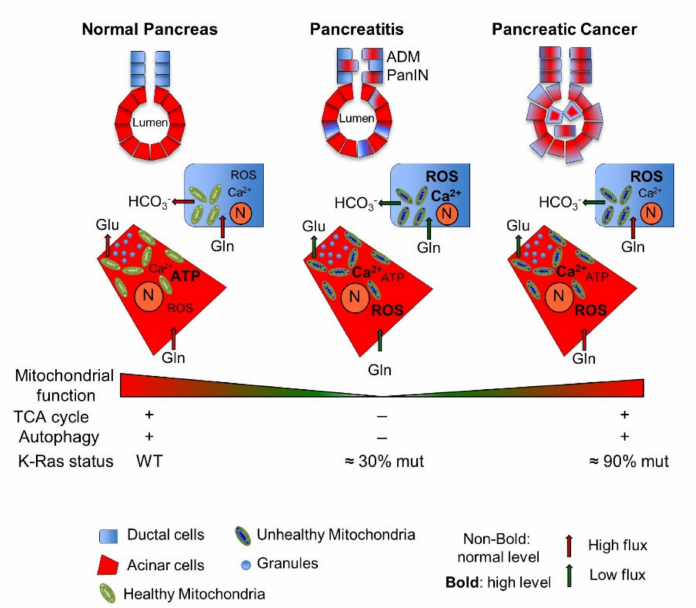
Figure 1. Schematic view of mitochondrial function and activity under physiological and pathological conditions in normal and cancer pancreatic